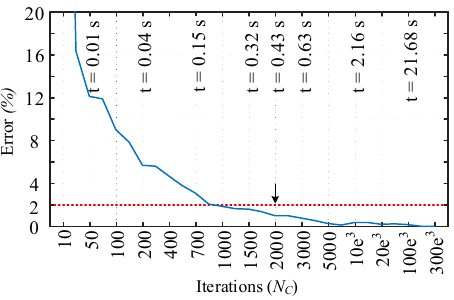
Figure 3. Stopping criterion for the maximum damping factor (SCR = 1.67, P = P n ).